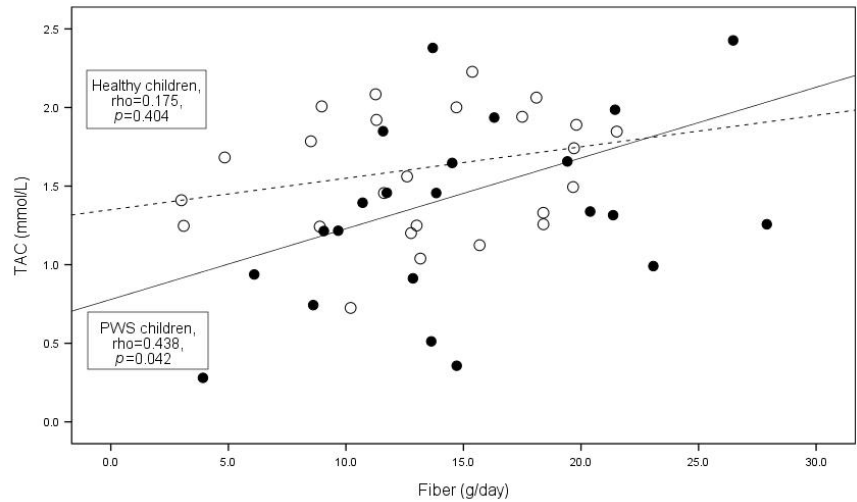
Figure 2. Associations between TAC values and fiber intake in children with PWS and controls. Black circles—PWS children, white circles—healthy children. Lines represent quantile regression.